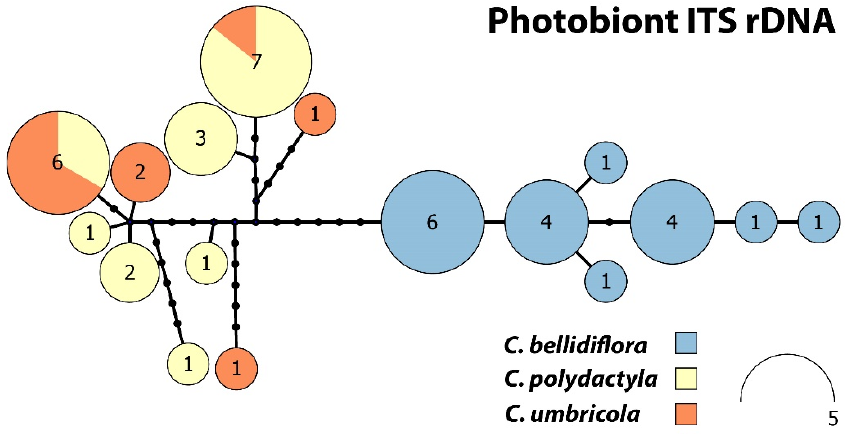
Figure 4. Haplotype network for Cladonia bellidiflora , C. polydactyla and C. umbricola , based on photobiont ITS rDNA.